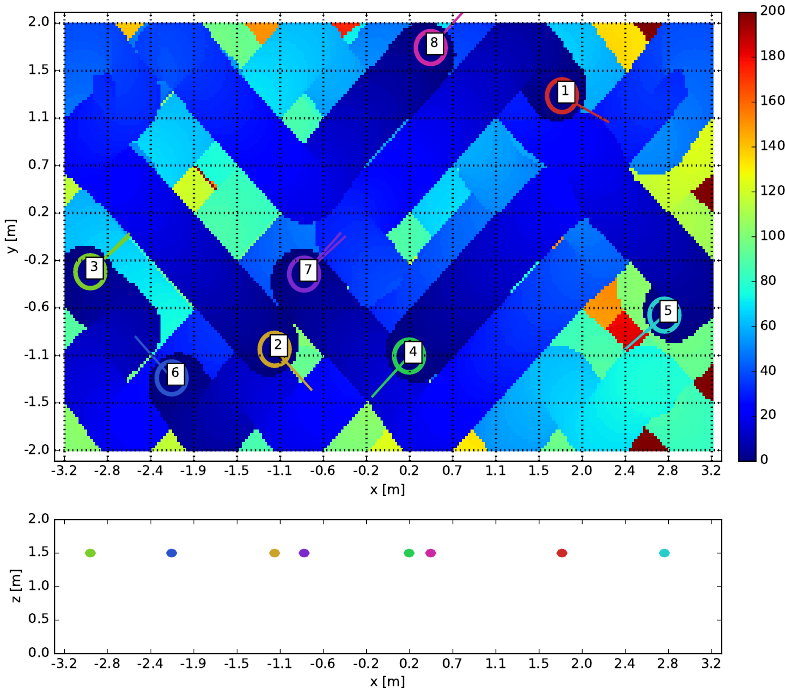
Figure 4. Example of surveillance mission with 8 drones and a nominal speed of 0.10 m/s after 300 s. The colored background represents the age of each cell. In the plot below, the position of the agents in the xz plane has been